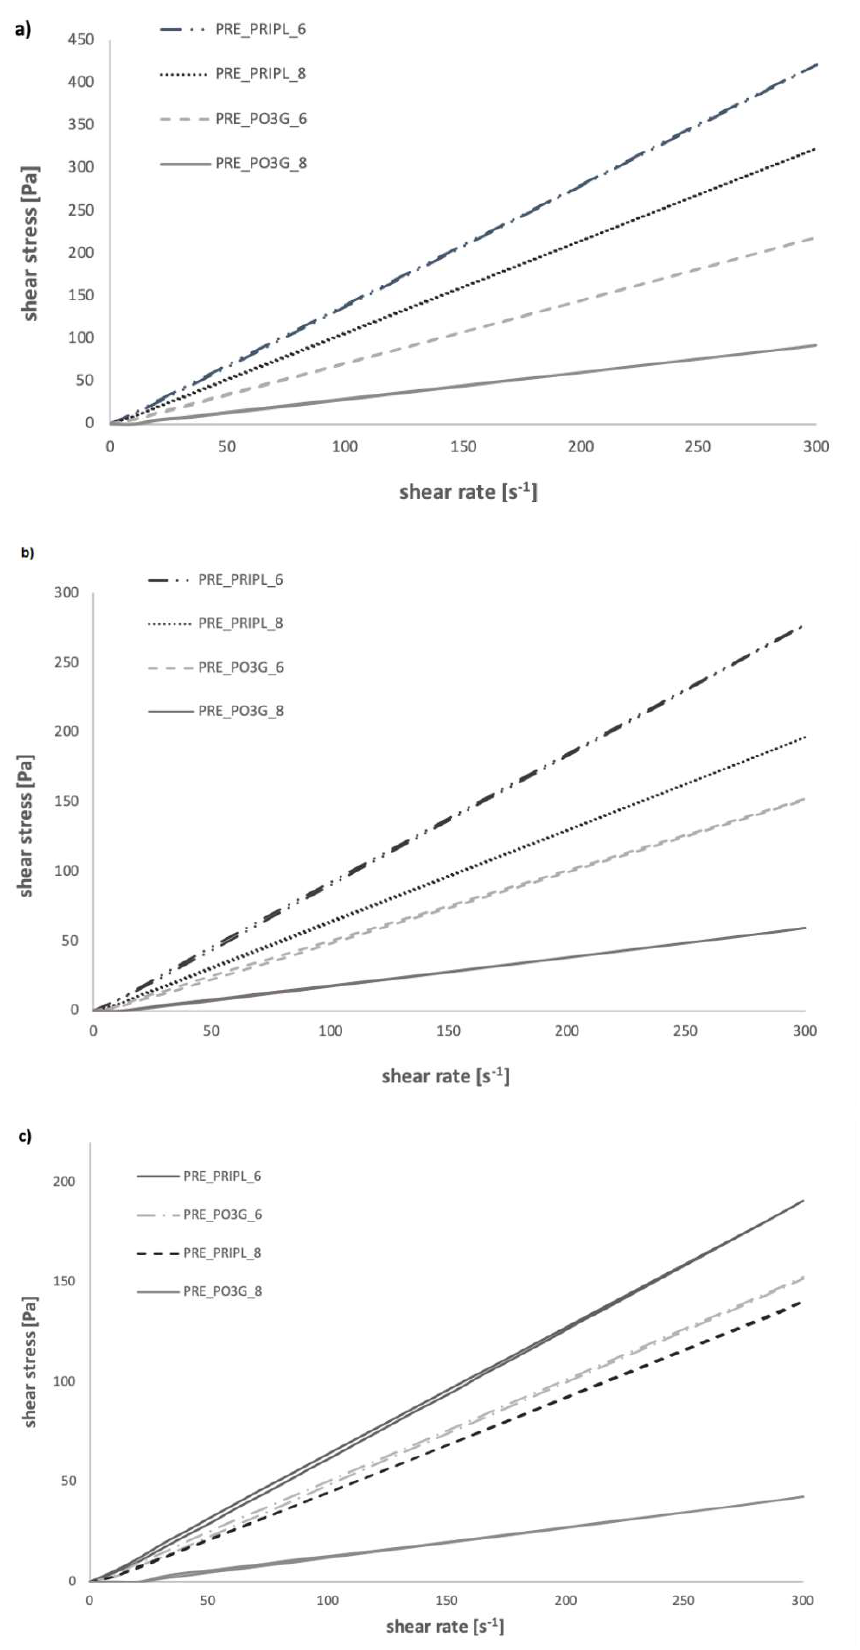
Figure 6. Flow curves of the synthesized bio based polyols at ( a ) 60 °C, ( b ) 70 °C, ( c ) 80 °C.